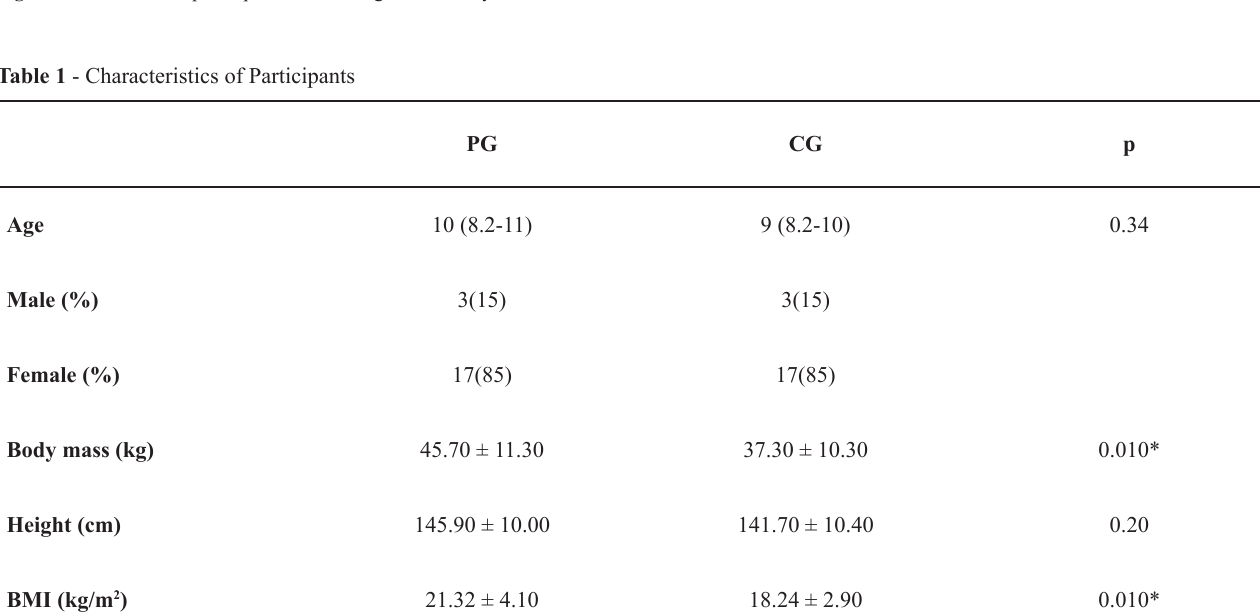
Figure 2 - Flowchart of participants at each stage of the study